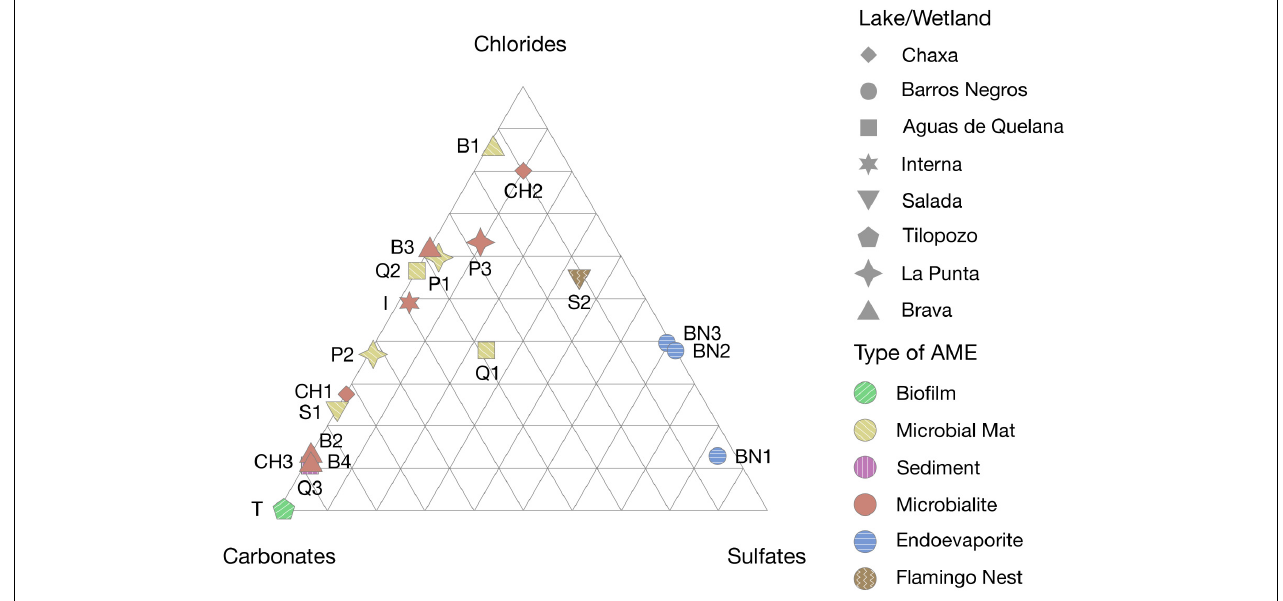
FIGURE 3 | Ternary diagram representing the mineral composition of the AMEs. The shapes and colors indicate the location and type of AME,